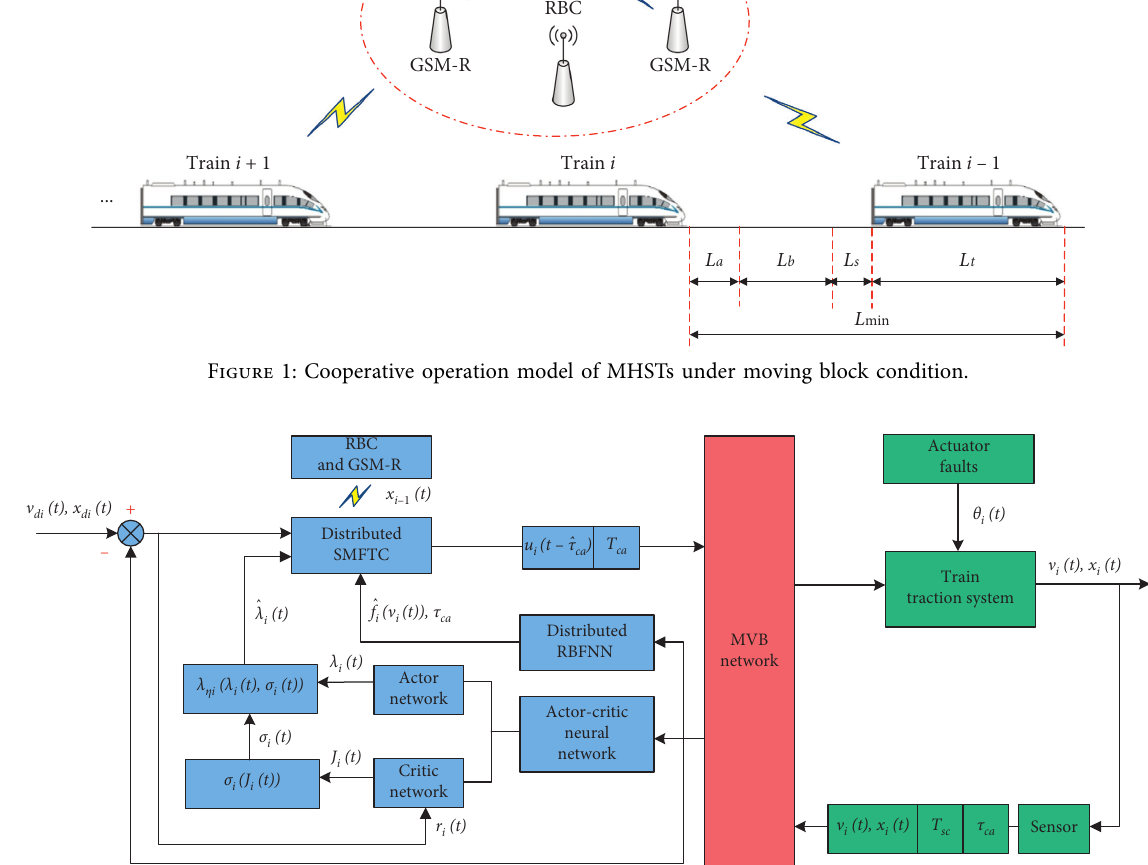
Figure 2: The diagram of the proposed fault-tolerant control